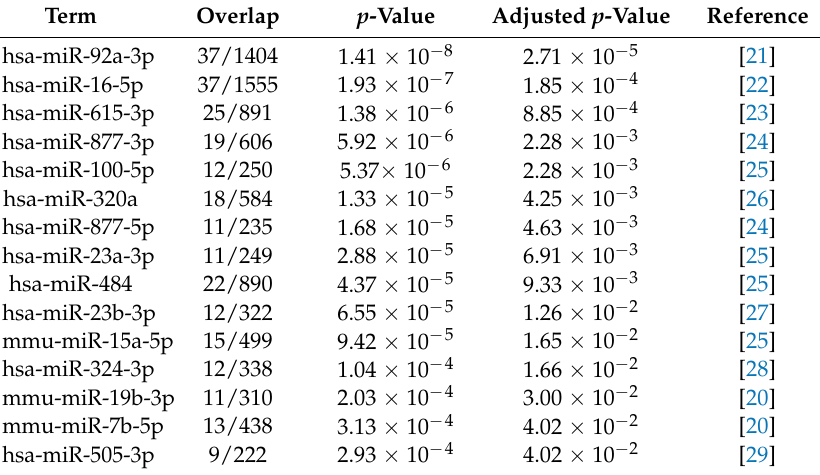
Table 5. “miRTarBase 2017” in Enrichr when 244 gene symbols were uploaded.